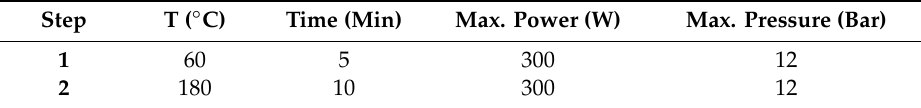
Table 1. Microwave conditions used for the synthesis of